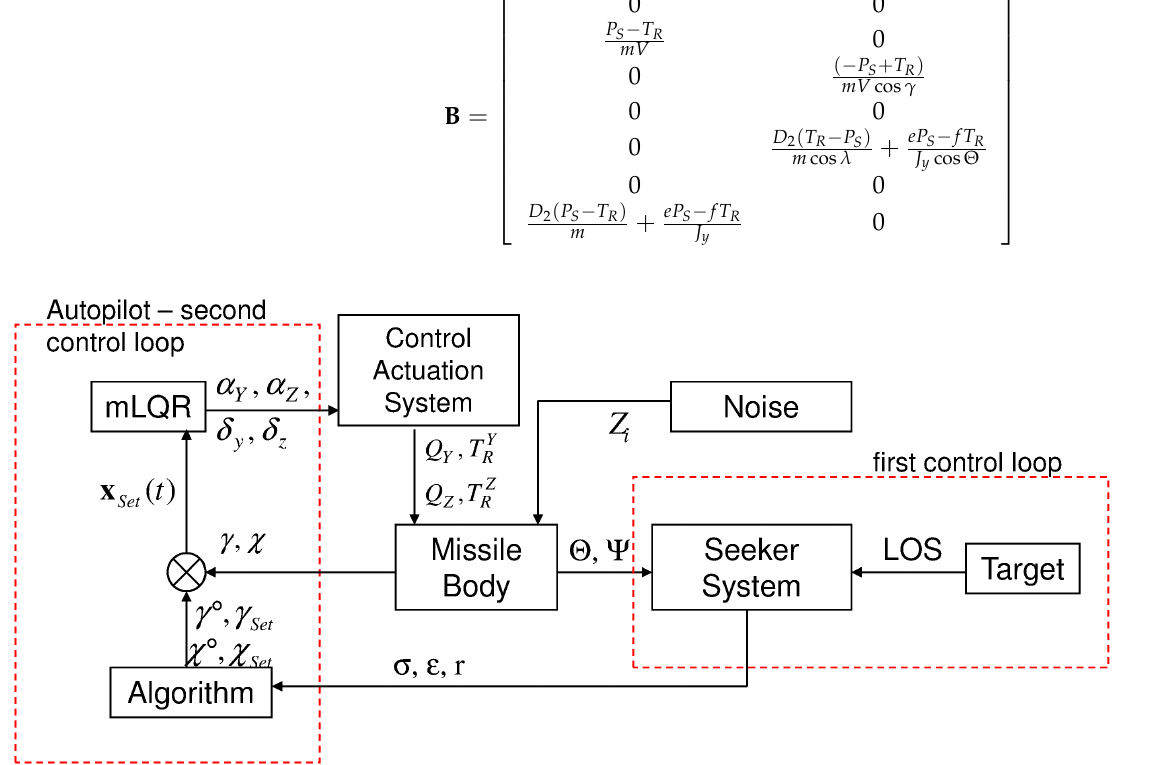
Figure 4. Scheme of controlling a hypothetical missile using a modified LQR method.